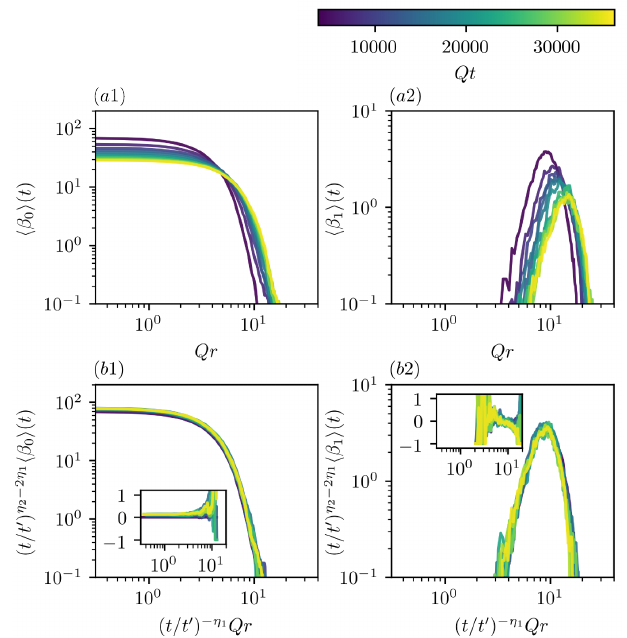
Figure 14: Betti number distributions for ¯ ν = 0.2 are shown for dimensions (cid:96) as indicated. The employed time-dependent scaling exponents are displayed in Fig. 8, setting η (cid:48) : = η . Insets show corresponding 1 1